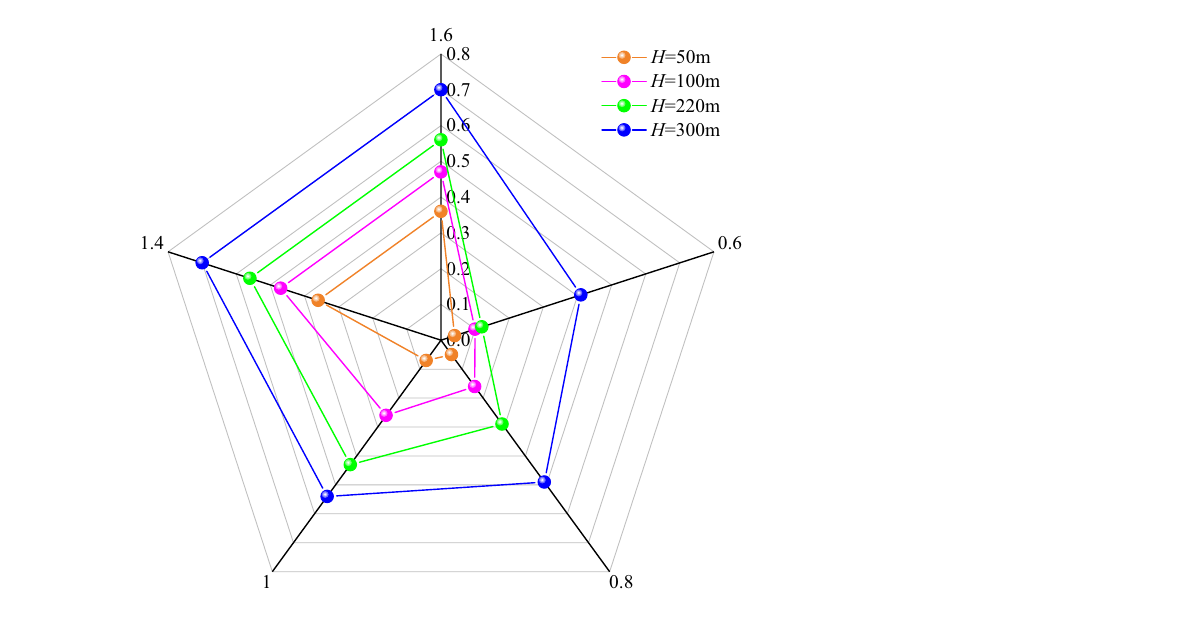
Figure 12. Relationship between D / H and W / M